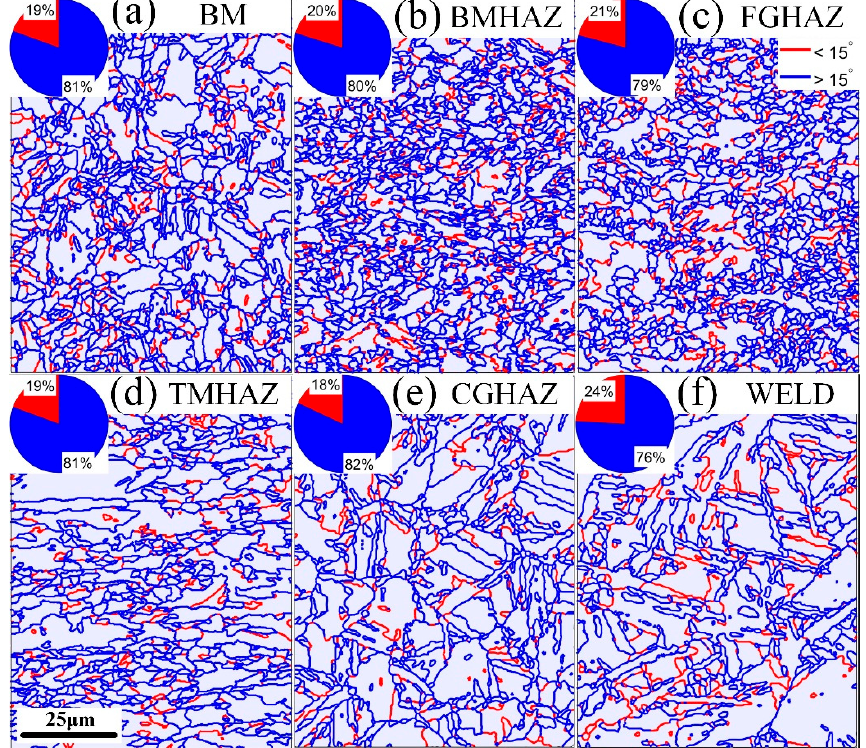
Figure 6. Distribution and proportion of high-angle and low-angle grain boundaries in BM ( a ), BMHAZ ( b ), FGHAZ ( c ), TMHAZ ( d ), CGHAZ ( e ), and WELD ( f ) of the X100 laser-welded joint.